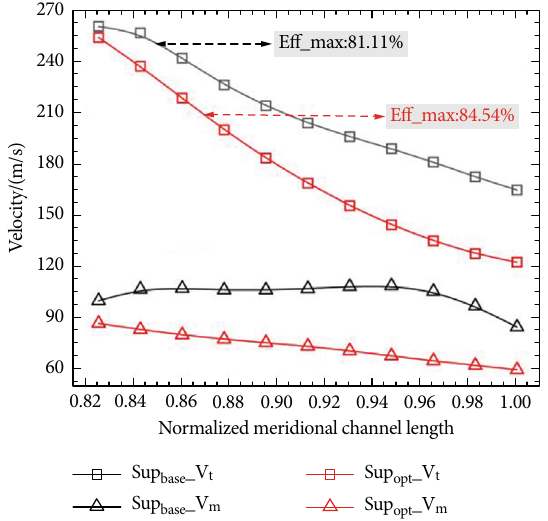
Figure 16: Velocity distributions for the di ff user of the supersonic compressor.